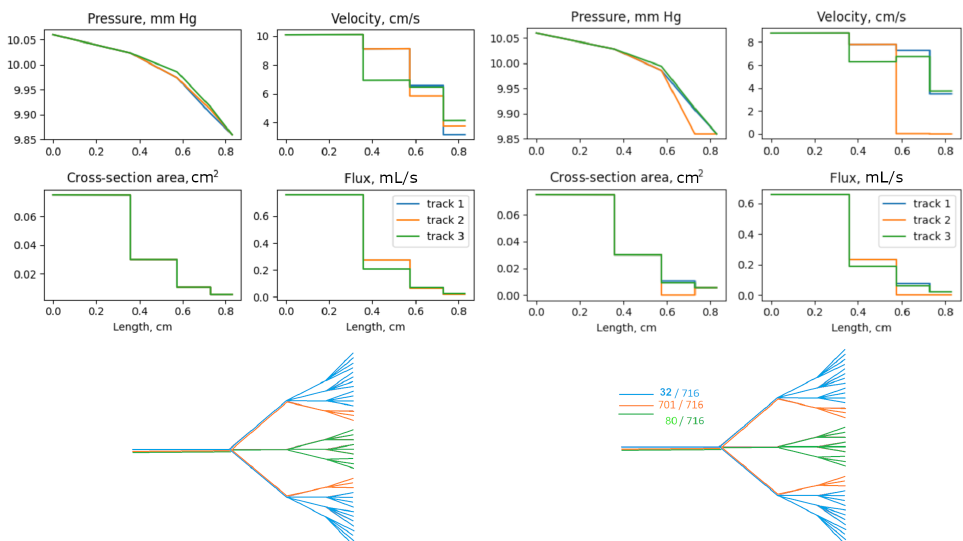
Figure 9. Pressure, velocity, cross-section area and flux distributions in the network without inflamed vessels ( left ) and with inflamed vessels ( right ). The final clot size (in µ m) and the vessel height (in µ m) for the vessel in the tenth level with the corresponding color are shown in the bottom. Different paths are shown with different colors. Colors of the graphs for pressure, velocity, cross-section area and flux correspond to colors of vessels in the